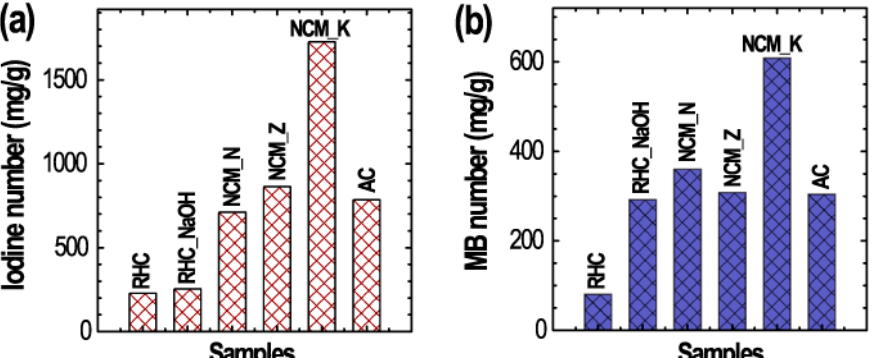
Figure 6. Results obtained from iodine and methylene blue adsorption: ( a ) Iodine numbers of RHC, RHC_NaOH, NCM_N, NCM_Z, and NCM_K, and ( b ) Corresponding methylene blue (MB)